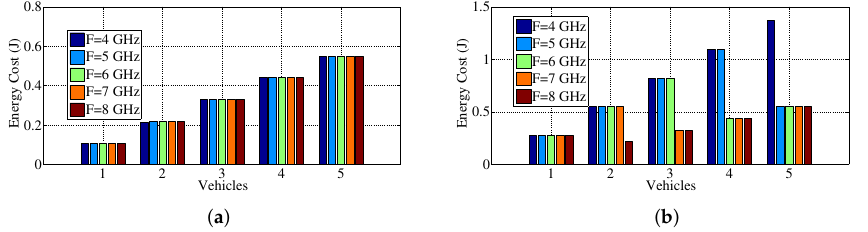
Figure 5. The impacts of the capacity of the VEC server on the energy cost. ( a ) γ i , t = 0.2, γ i , e = 0.8; ( b ) γ i , t = 0.5, γ i , e = 0.5.